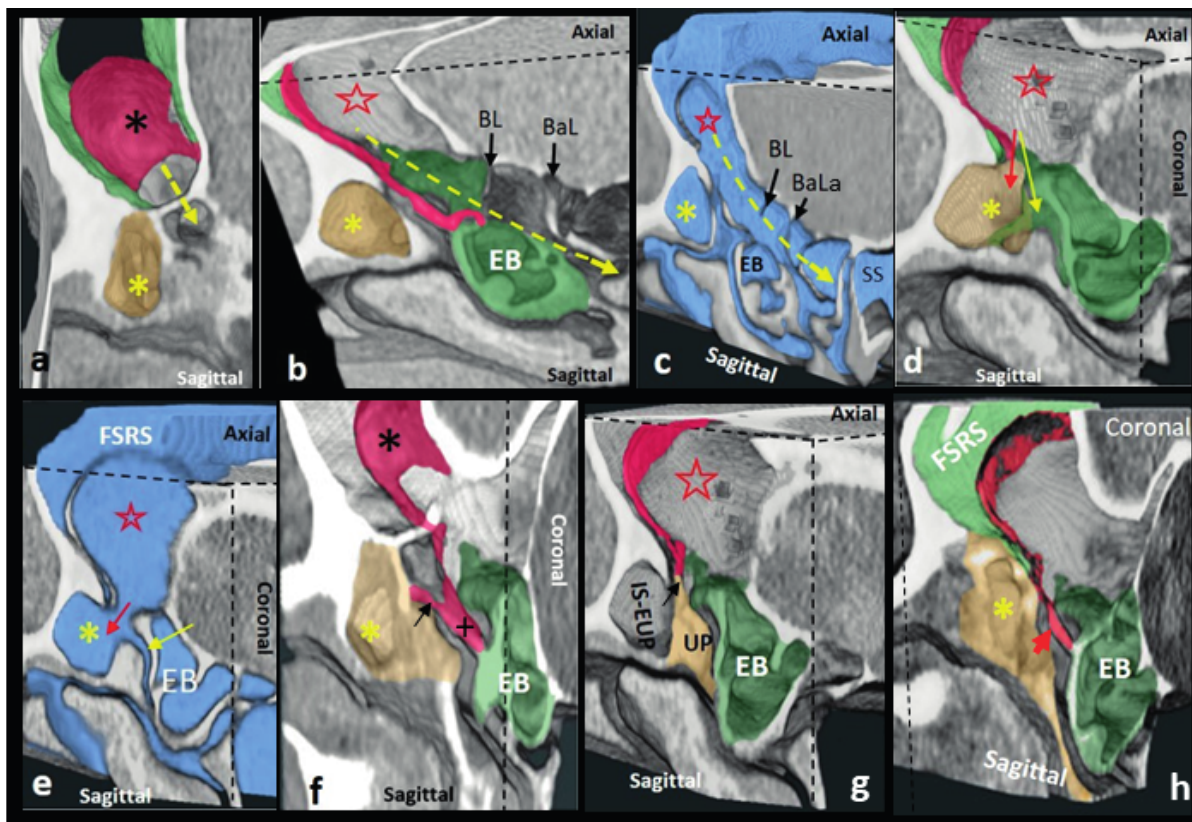
Figure 4. “Frontal Bulla”- a pneumatized Space in the Frontal Sinus. a. 3D obliqued sagittal image (right side) reveals a “bullous” expansion medially (black asterisk, red outline) and expanding laterally, within the FSRS (light green outline). The “bulla” has a solid attachment to the anterior wall of the FS, and a “feathery” attachment to the posterior wall of the FS. An opening is present within the medial “bulla” (yellow dashed arrow), revealing a direct communication between the Frontal Bulla and the FSR, and the antero-superior ethmoid sinus. IS-EUP (gold outline, yellow asterisk). b.-e. A variety of 3D obliqued sagittal images, revealing in fig. b a “string like” lamellar attachment (red outline) between the “bulla” in the FS and the Ethmoid Bulla (dark green, EB). Note that the Ethmoid Bulla extends forward into the FR and posterior FS, and that there is a gap in the Bulla Lamella (BL, black arrow) affording communication from FS and “bulla” through the FR into the superior meatus as there is also a gap in the Basal Lamella (Ba La) (dashed yellow arrow). Findings are confirmed in fig. c with the 3D display of air (blue outline) within the FS, “bulla”, anterior and posterior ethmoid sinuses. Gold outline, yellow asterisk: IS-EUP; red star: “bulla” space; SS: Sphenoid Sinus. d.-e. Communication between the frontal “bulla” space (red star) with the IS-EUP (yellow asterisk) (red arrow) as well as the EI (yellow arrow). f.-h. 3D sagittal images at various obliquities revealing the anteriorly “string shaped” lamella emerging from the EB with a proximal “v” shaped configu- ration (+) (Fig. f) with its medial “branch” (black arrow) in figs. f and g, fusing with the uncinate lamella (gold outline), and the “lateral branch” is shown arising from the EB (red arrow) (Fig. h).